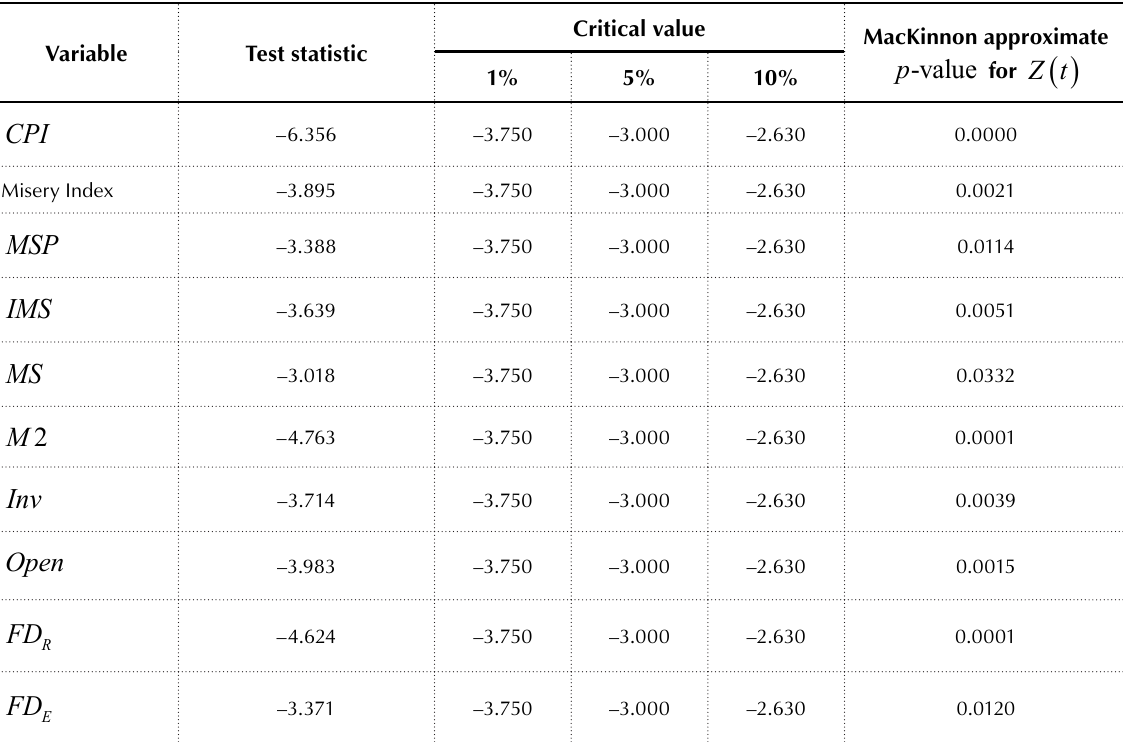
Table 3. Augmented Dickey-Fuller test statistics of dependent and explanatory variables of the regression equation (based on our own